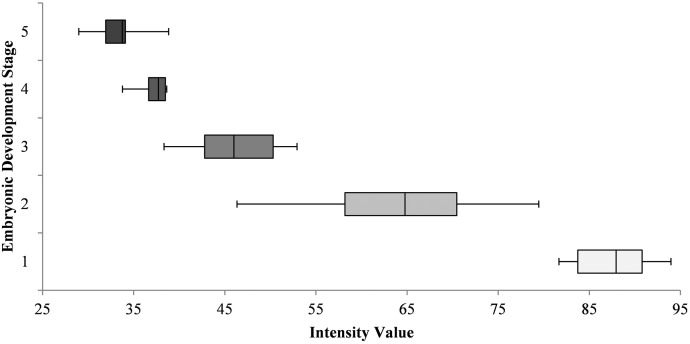
Range of gravid spot intensity values corresponding to fish with assigned embryonic stages of development. As fish carried more than one developmental stage (generally 2) they assigned to the most dominant developmental stage they carried.